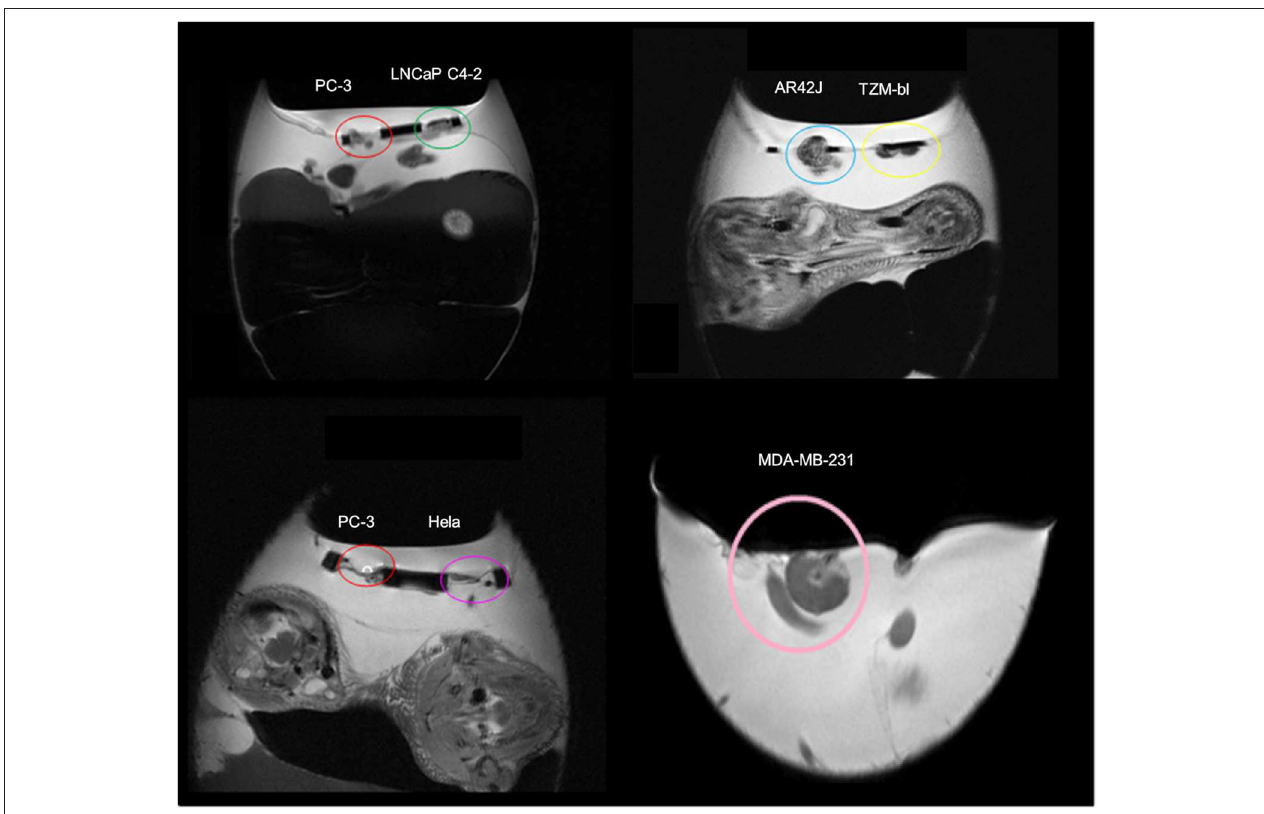
FIGURE 1 | Magnetic resonance images (MRI) of xenotransplanted tumors grown on the chorioallantoic membrane (CAM) from different cell lines (prostate cancer: PC-3, LNCaP C4-2; pancreas cancer: AR42J; adenocarcinoma: TZM-bl; cervical cancer: HELA; breast cancer: MDA-MB-231). Unpublished imaging material provided by Winter and